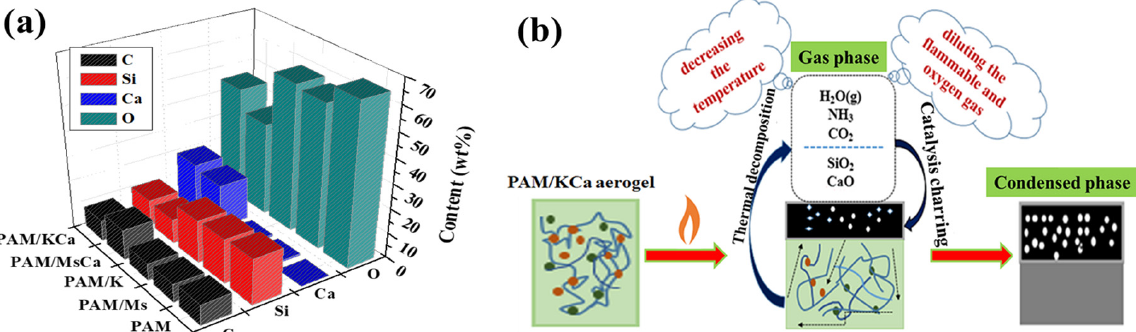
Figure 7. ( a ) Relative elemental compositions of the residues for the different PAM composite aerogels after cone calorimeter test by SEM–EDS measurement; ( b ) Schematic diagram of the possible flame retardancy mechanism of the PAM/KCa